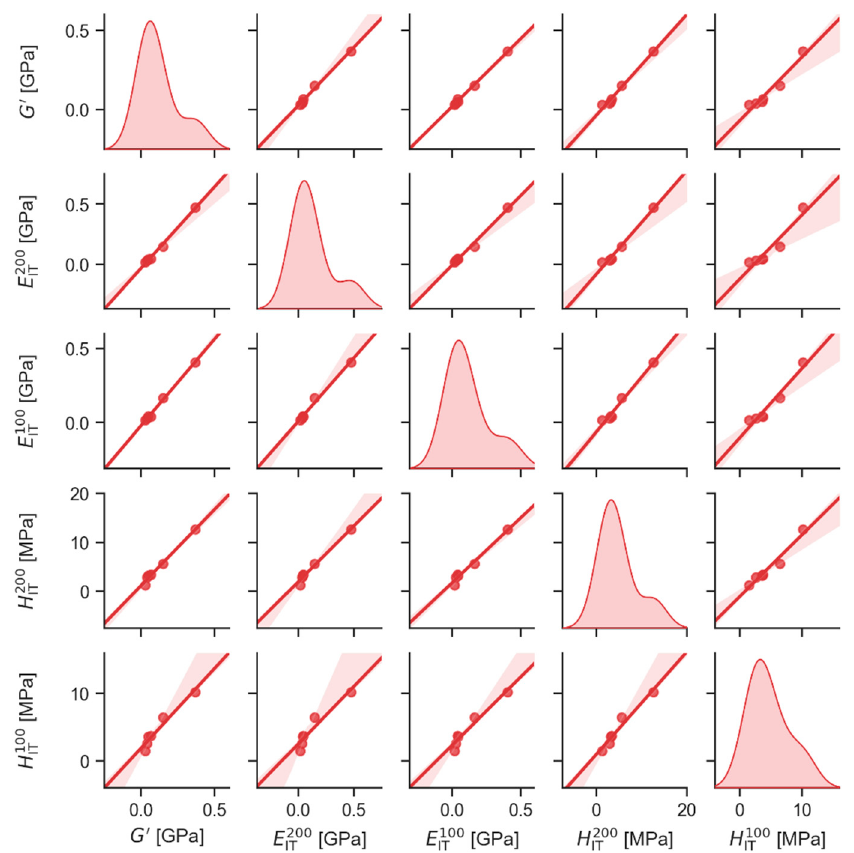
Figure 4. Scatterplot matrix graph showing the correlations between stiffness-related properties measured at macroscale (storage modulus, measured in shear: G’) and microscale (indentation modulus and indentation hardness: E IT and H IT, respectively). Both indentation modulus and hardness were measured at a higher loading force of 200 mN ( E 200 and H 200 ) and lower loading force of 100 mN ( E 100 and H 100 ). The diagonal elements of the scatterplot matrix graph show distributions of individual quantities, while off-diagonal elements show the correlations between each pair of quantities. The translucent bands around the linear regression lines represent the 80% confidence interval of the regression